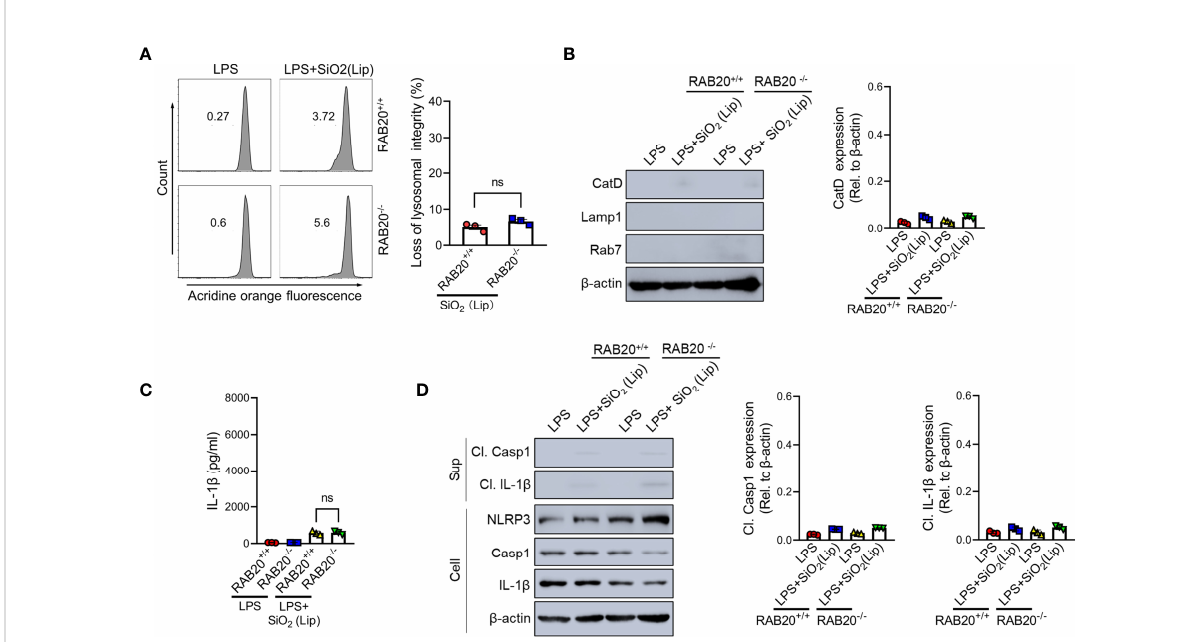
FIGURE 7 Reducing the contact between phagocytic membrane and silica crystals inhibits silica crystal-induced lysosomal rupture and IL-1 b release during RAB20 de fi ciency. (A) Immunoblotting for Cathepsin D, RAB7, Lamp1, and b -actin in the cytosolic fraction from RAB20 +/+ and RAB20 -/- mouse peritoneal macrophages stimulated with liposome-coated silica crystals after LPS priming. (B) Flow cytometry of RAB20 +/+ and RAB20 -/- mouse peritoneal macrophages that stained with acridine orange and then treated with liposome-coated silica crystals after LPS